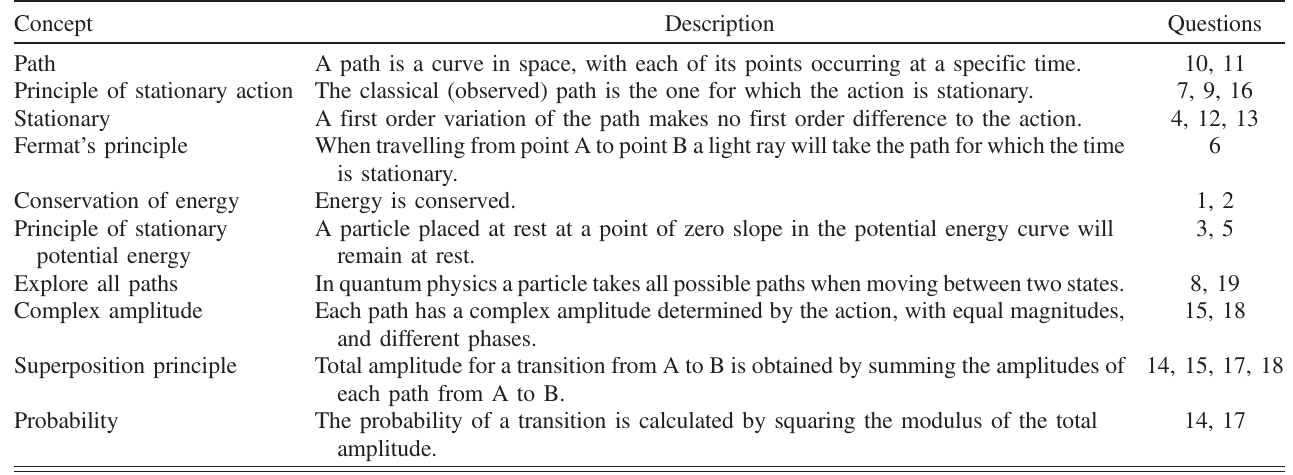
TABLE I. The concepts tested by the ACI. In the questions column are the question numbers we classified as associated with each concept. The questions are available in the Supplemental Material [6].